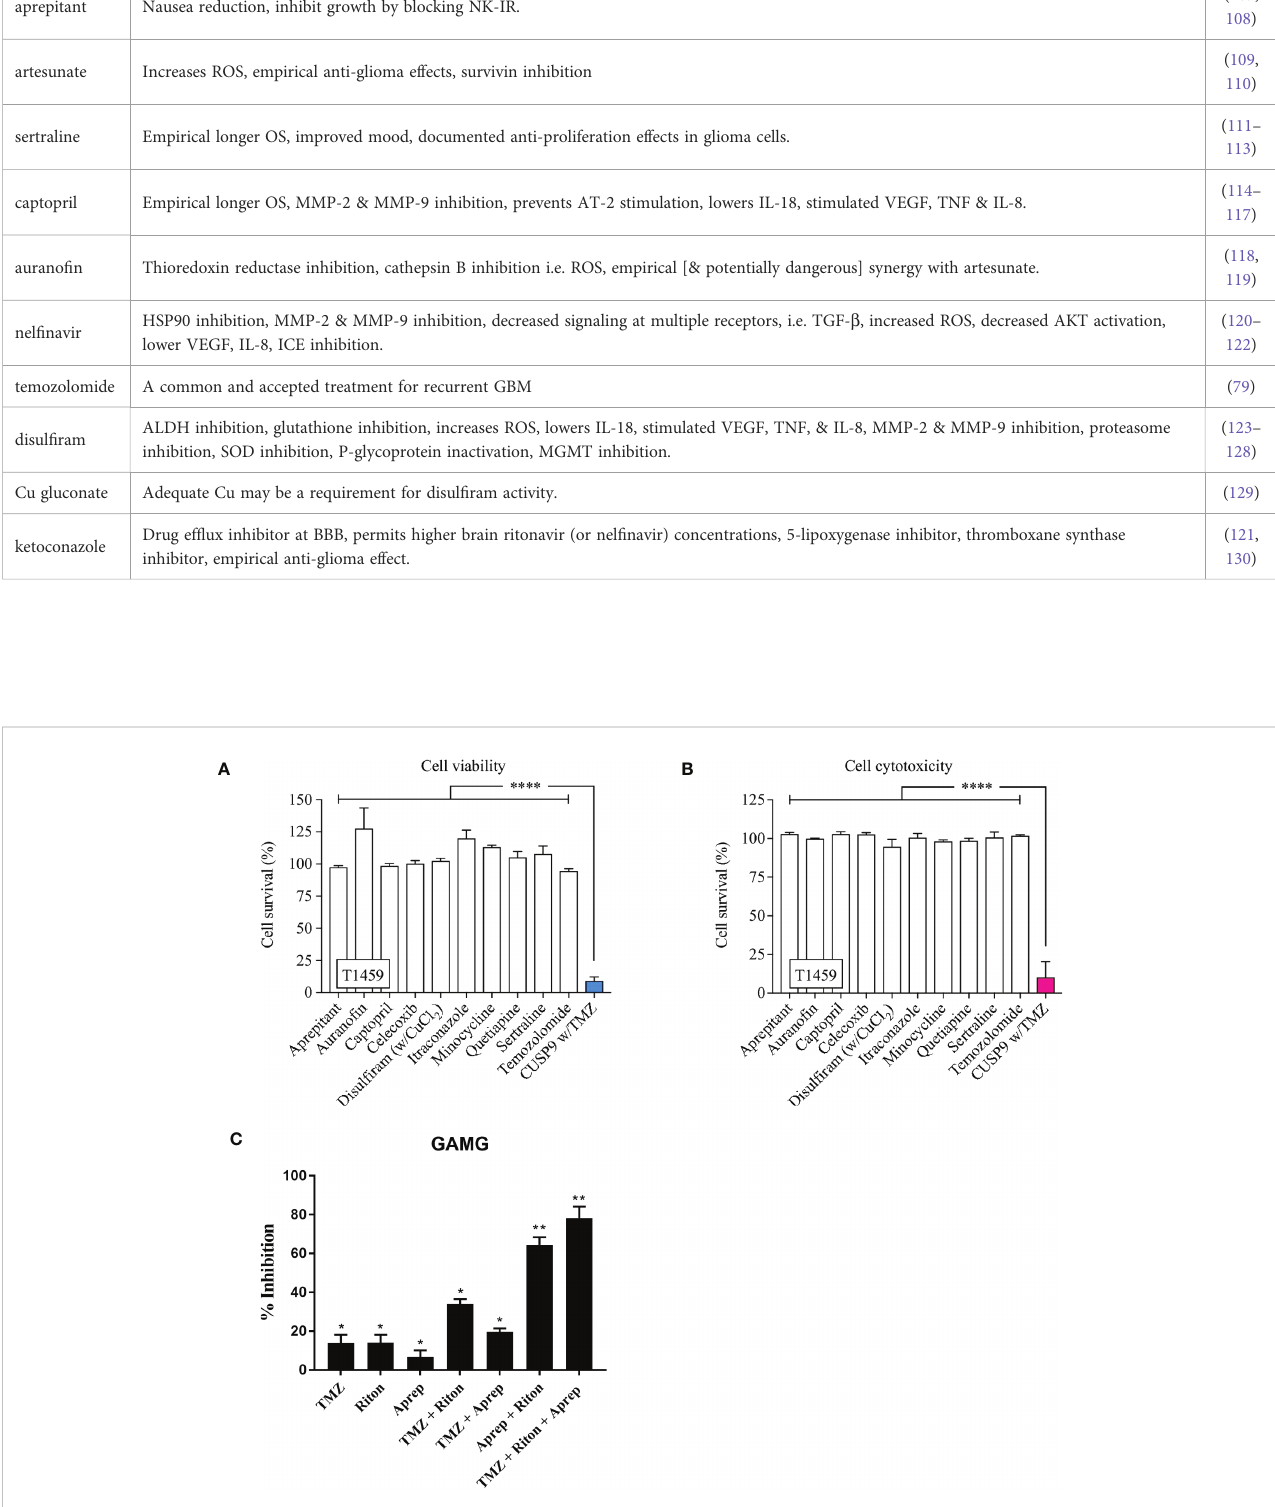
TABLE 2 List of CUSP9 drugs and their expected bene fi t in treating GBM. Adapted from Kast R.E., 2013 (106). DRUG EXPECTED BENEFIT REF. aprepitant Nausea reduction, inhibit growth by blocking NK-IR.